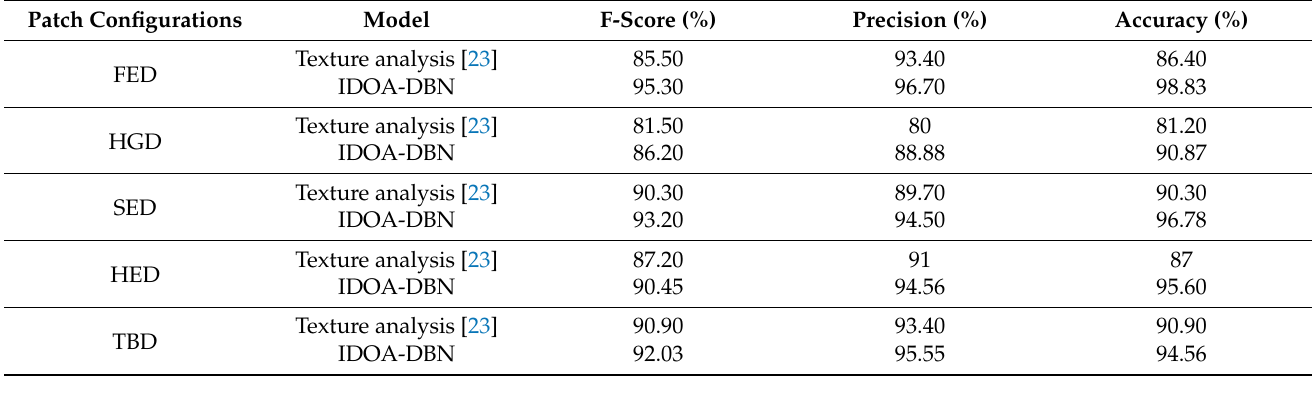
Table 4. Results of various patch configurations.